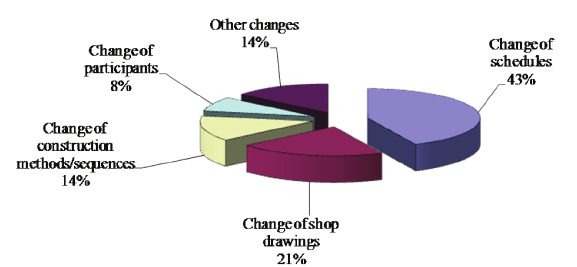
Fig. 6. Percentage for various categories of change in the case study